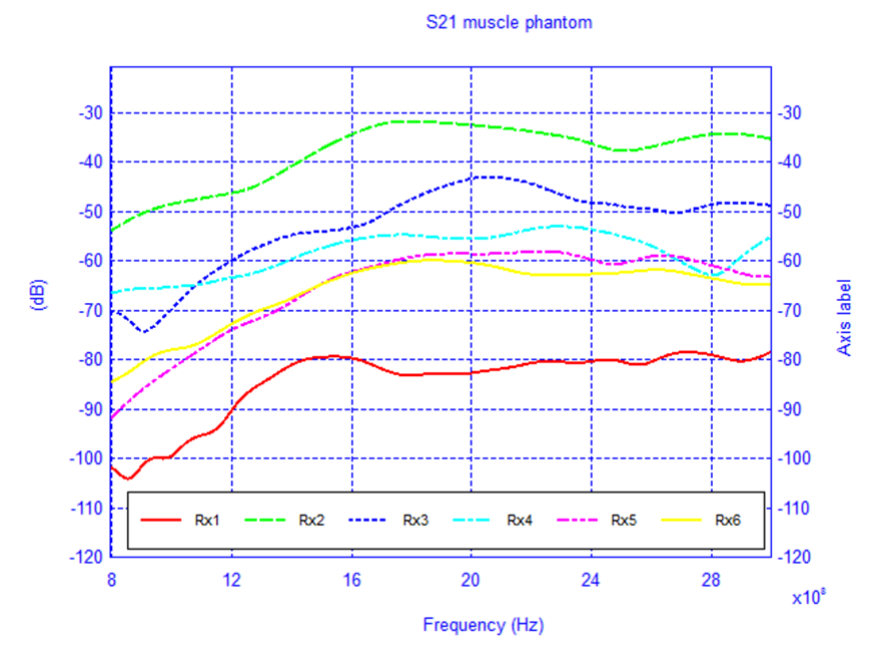
Figure 17. S of the BAN network scenario with muscle phantom. 21